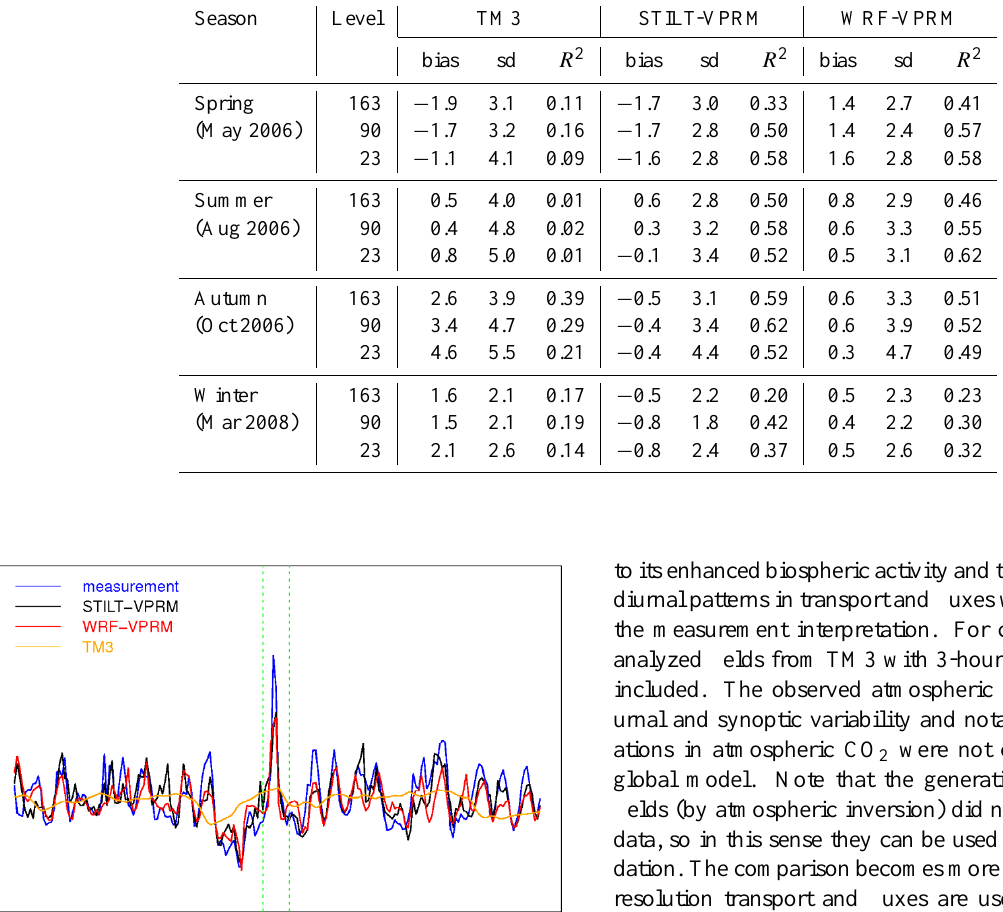
Table 2. Summary statistics of observed and simulated CO 2 fields (model bias (bias), standard deviation of the differences (sd) and squared